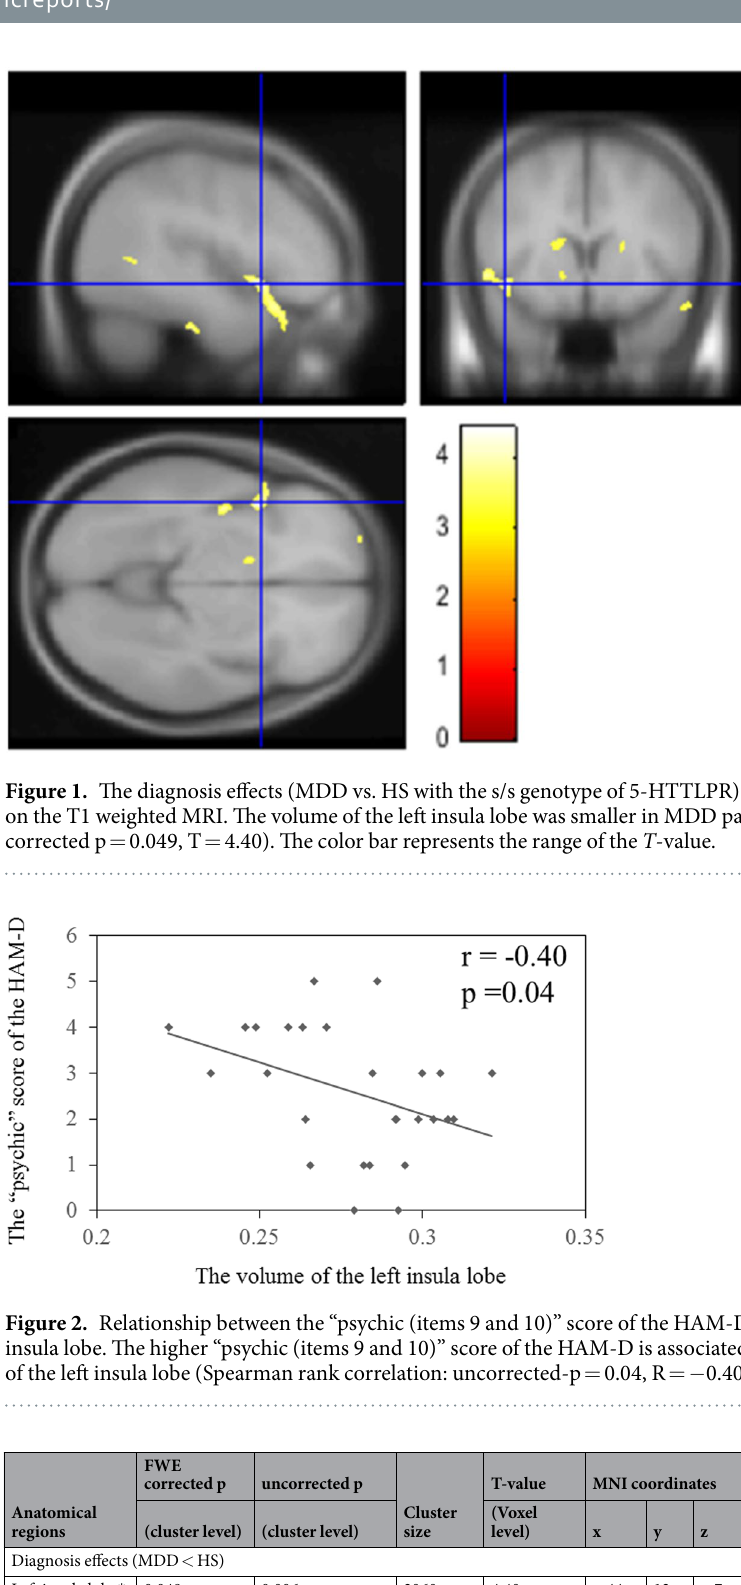
Anatomical regions